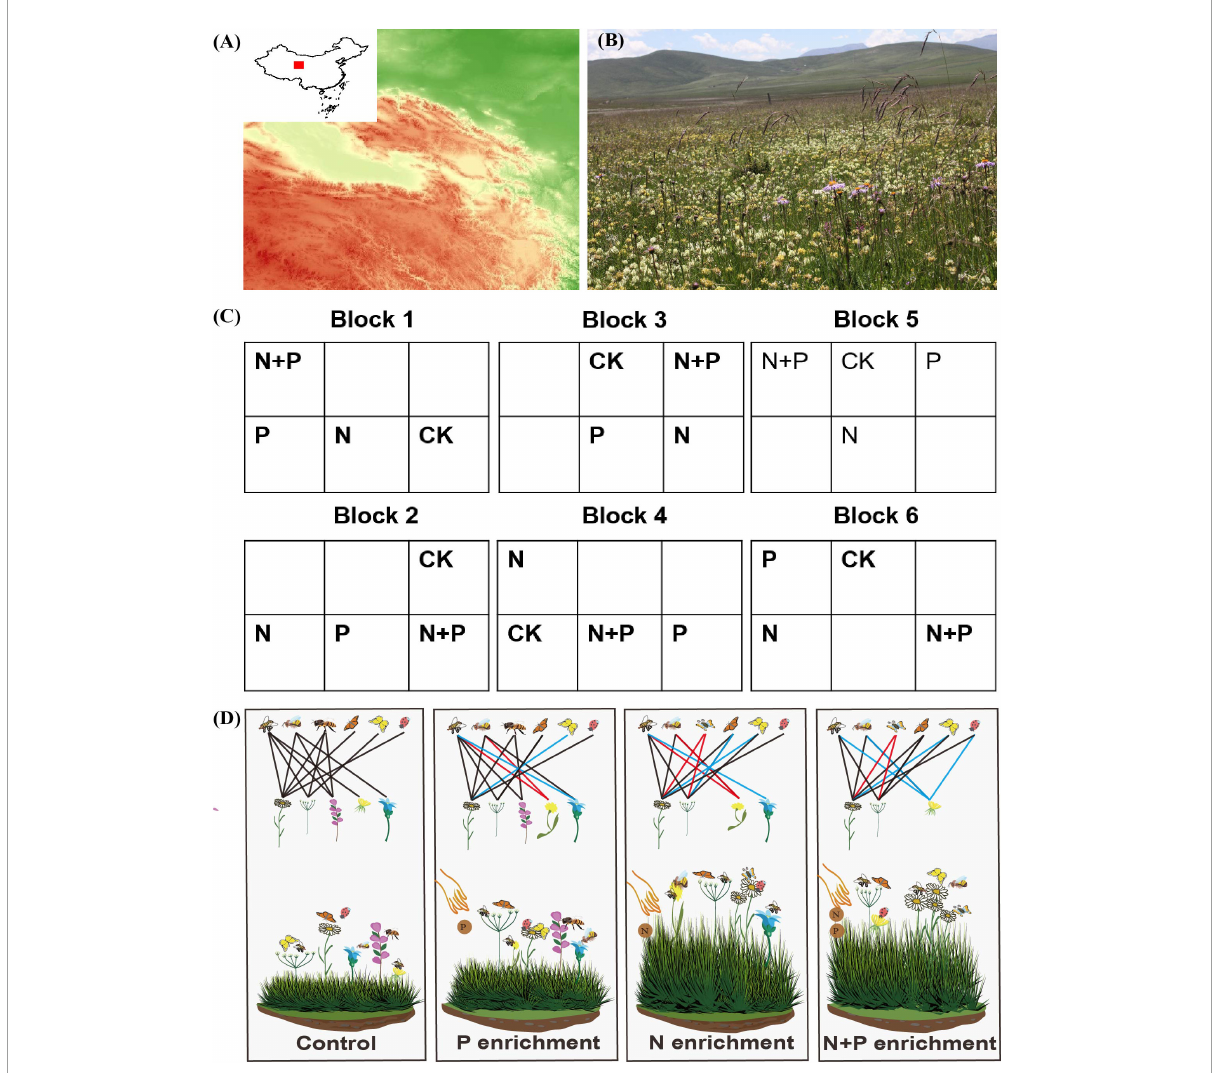
FIGURE1 Description of study area and experiment design. (A) Location of the study area in the northeastern Qinghai-Tibet Plateau, Qinghai, China. (B) Alpine grassland landscape of the study site and legumes, which are in full bloom (taken by Lin-Lin Wang, July 30, 2017). (C) Study design shows 24 plots in the N and P enrichment plots. CK represents the control plots. Two empty plots in each block indicate not included in this experiment. (D) Schematic framework of how N and P enrichment affects the diversity of flowering plants, pollinator communities, and plant–pollinator interactions. The colored links identify the changes in plant and pollinator interactions due to nutrient enrichment. Pictures of (D) are available at